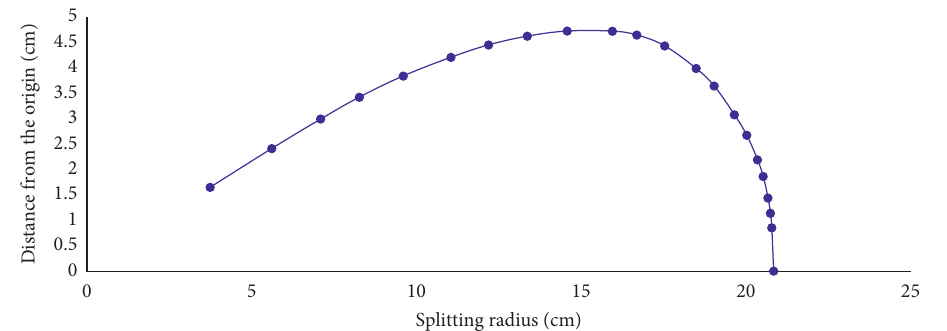
Figure 7: Contact bond damage range envelope curve.